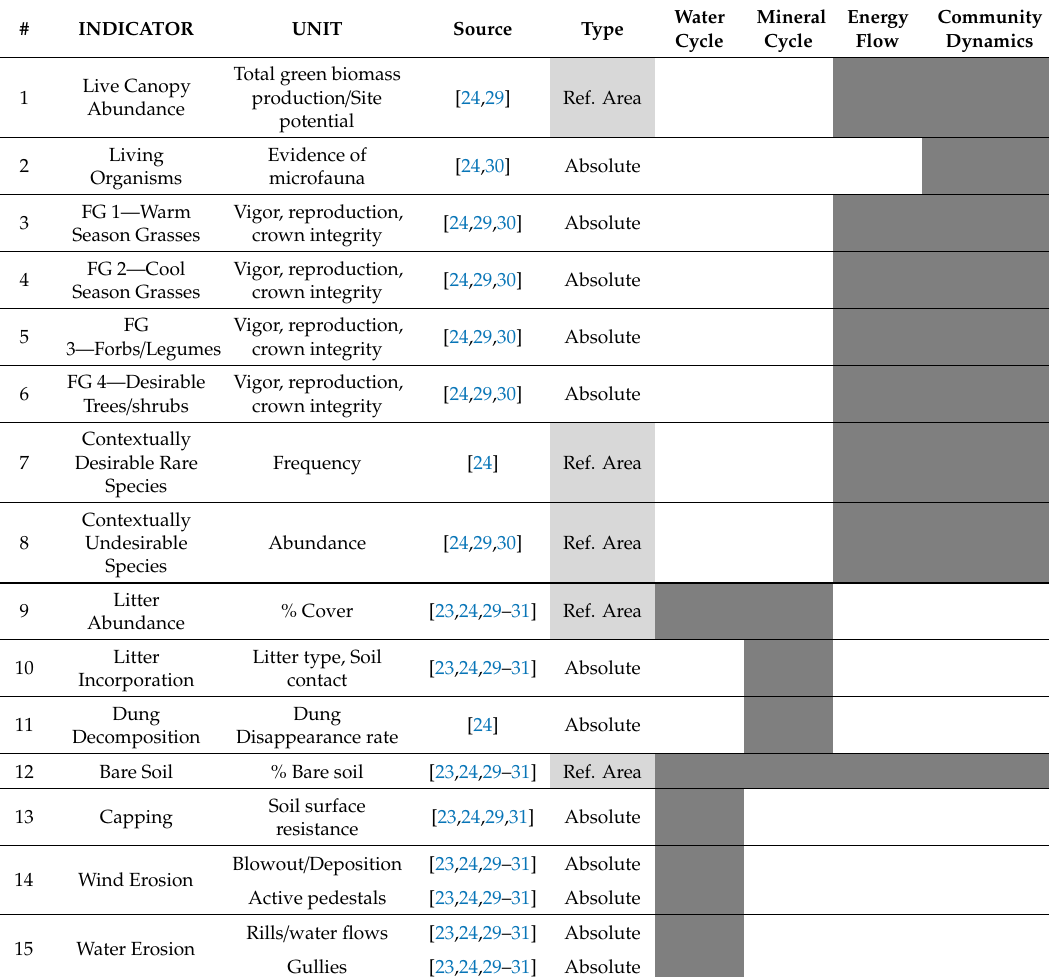
Table 2. Ecological processes and related indicators evaluated for Ecological Health Index (EHI). The Type columns explains if the indicator is evaluated as compared to the reference area or as a stand-alone, absolute indicator. The latter four columns indicate which of the key four ecosystem cycles this is an indicator of (white, not an indicator; gray, an